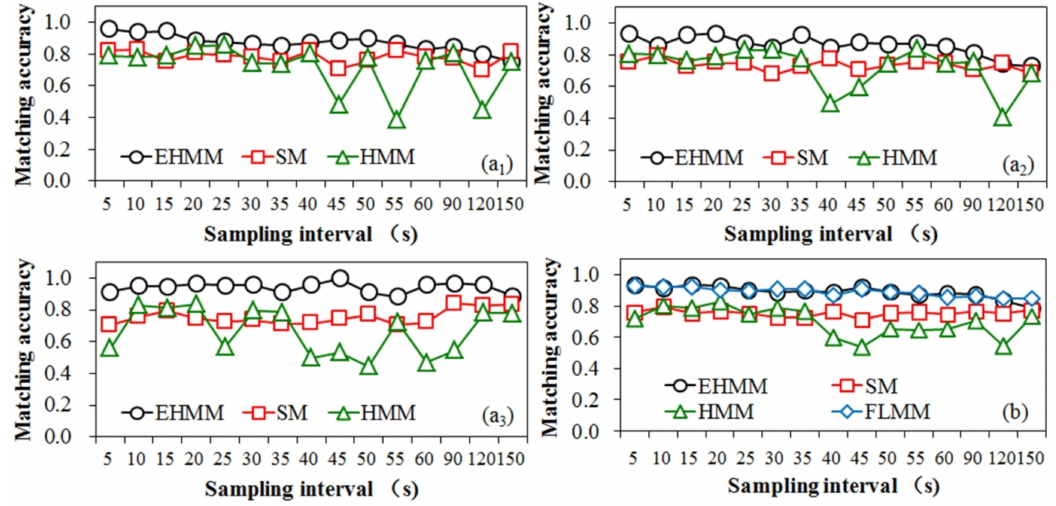
Figure 7. Comparison of matching accuracy at various sampling intervals based on dataset 1. In ( a ), the subscript numbers 1, 2 and 3 denote the first, second and third samplings, respectively, in dataset 1. ( b ) represents the average matching accuracies among the three samplings.